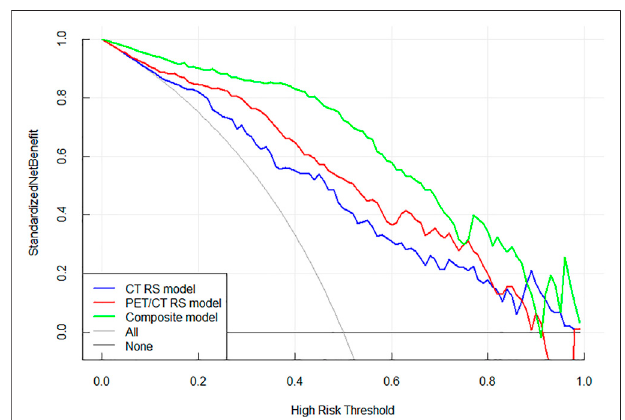
FIGURE 5 | Decision curves of the three models. The green line represents the composite model incorporating mixedRS and EGFR. The blue andredlinesrepresentCTRSmodelandPET/CTRSmodel,respectively.The grey line indicates the assumption that all patients possess the gene mutation, while the black line indicates the assumption that all patients possess the wild type